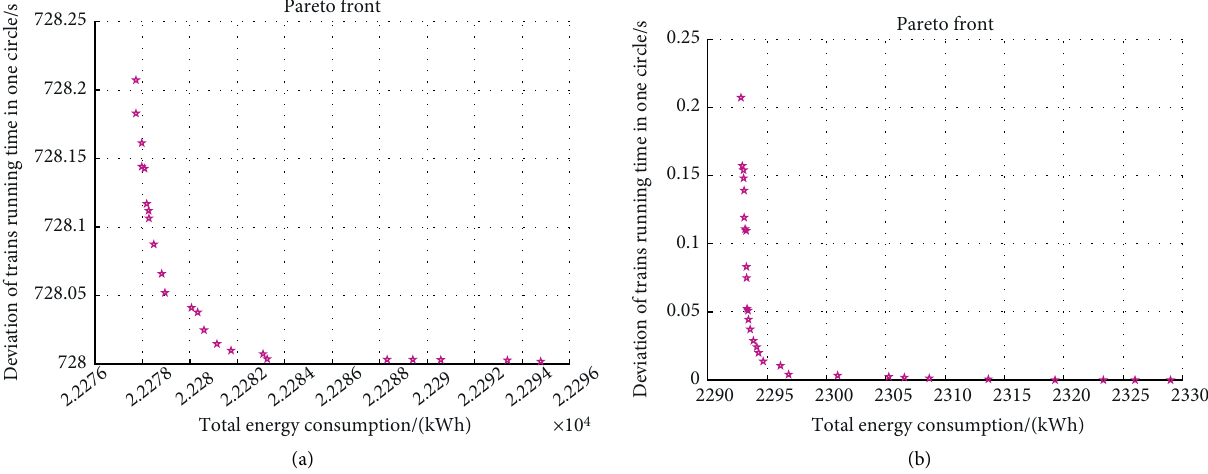
Figure 19: The Pareto front under and OIC = 0.3. (a) The Pareto solutions of the OEST. (b) The Pareto solutions of the 𝐺 = 200